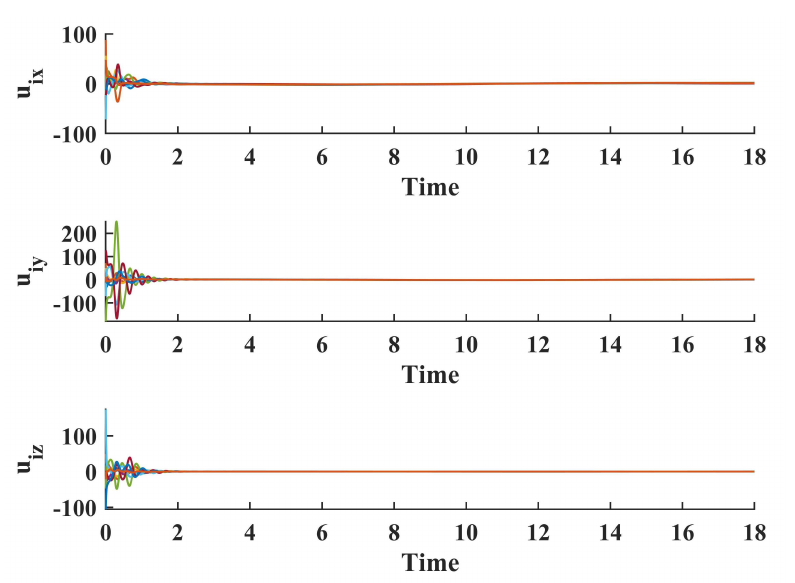
Figure 8. Control inputs for dynamic